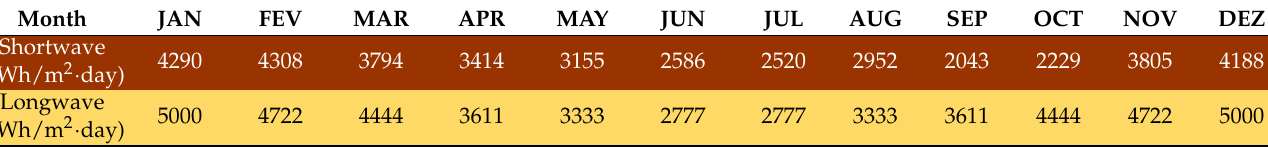
Table 1. Monthly variation of the short and longwave solar radiation in Balne á rio Cambori ú /SC (Wh/m 2 · day).